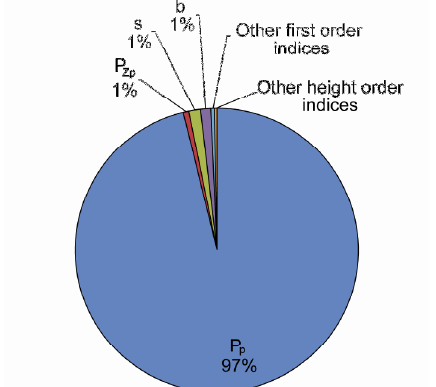
Fig. 16. Results for the fourth